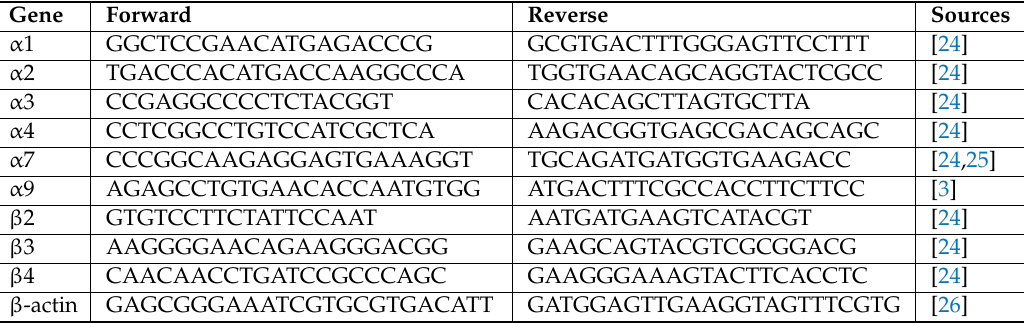
Table 1. Primer sequence of genes used for